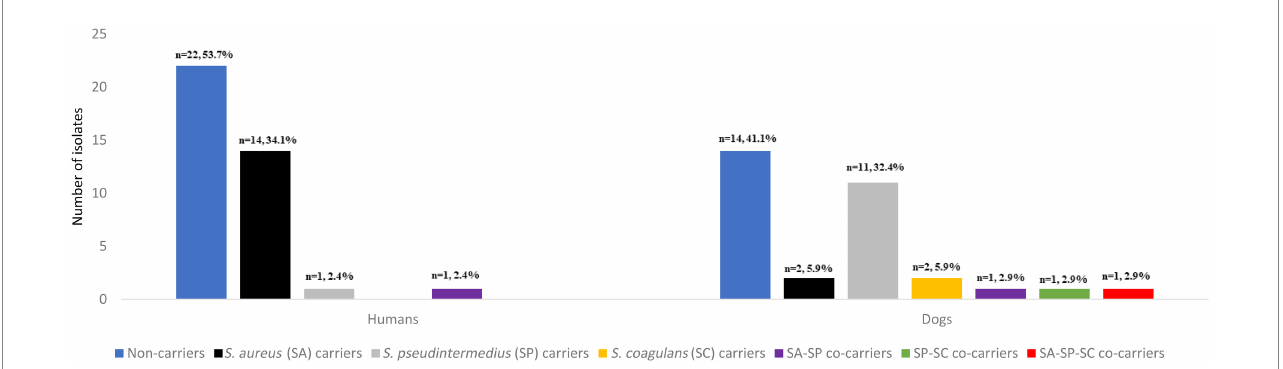
TABLE 1 Association of household density with nasal S. aureus and S. pseudintermedius carriage. Household S. aureus density